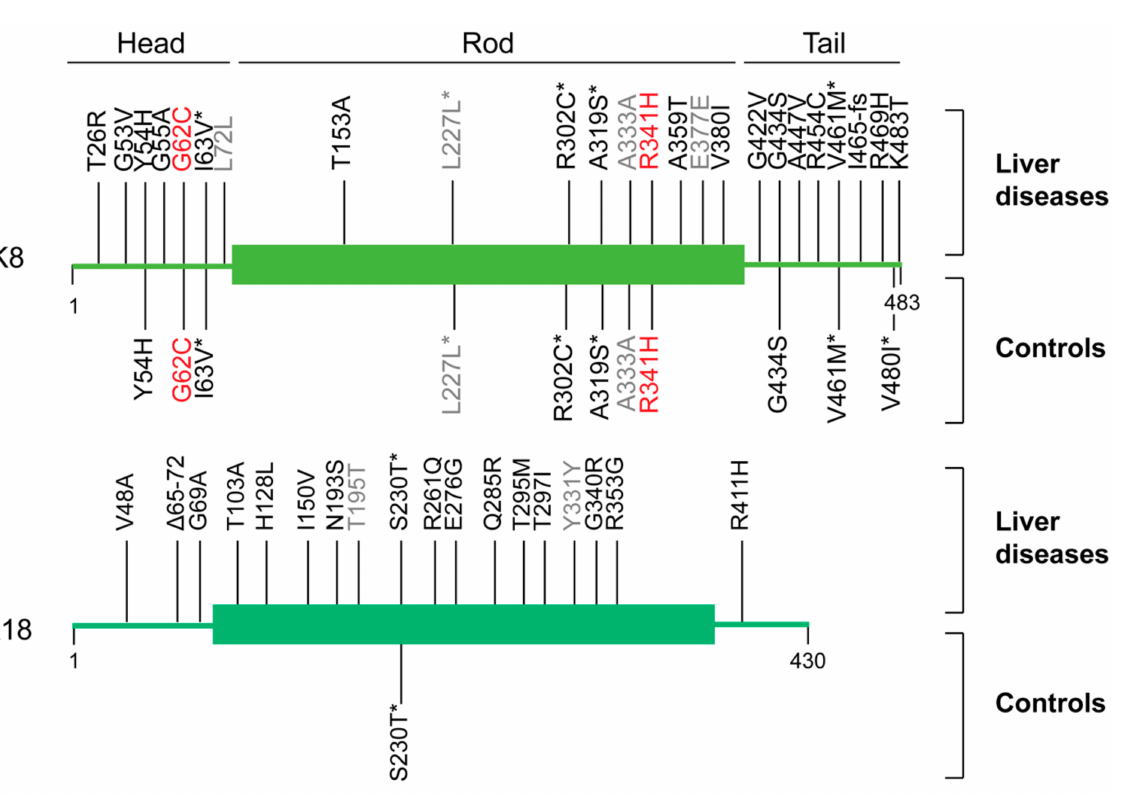
Figure 1. Distributions of K8/K18 variants found in patients with liver diseases and controls: The protein subdomains and amino acid positions of K8 and K18 are indicated. The K8/K18 variants are illustrated on a diagram of K8/K18. The variants in red are the mutations studied with transgenic mouse models, while the variants in grey are silent mutations. The mutations with an asterisk (*) indicate polymorphisms, since the mutations have been found in the liver disease groups and the controls with similar mutation frequency. The K8/K18 mutations were analyzed in the studies of Strnad P et al., Li R et al., Zhong B et al., Ye J et al., and Ku N.O. et al.